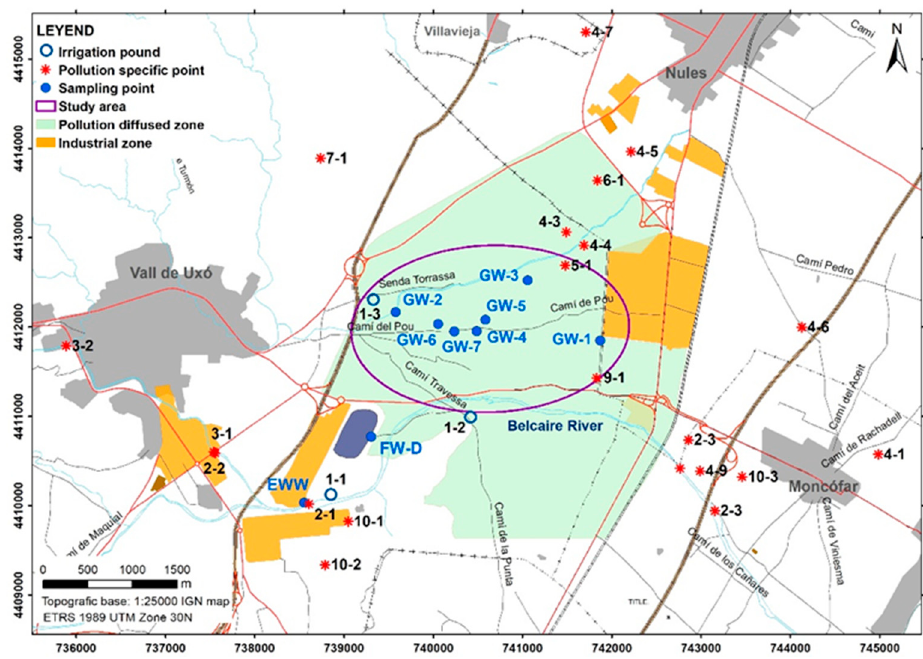
Figure 5. A real view of the Rambleta area and surroundings. Location of sampling points, pollution specific points, and pollution diffused areas.